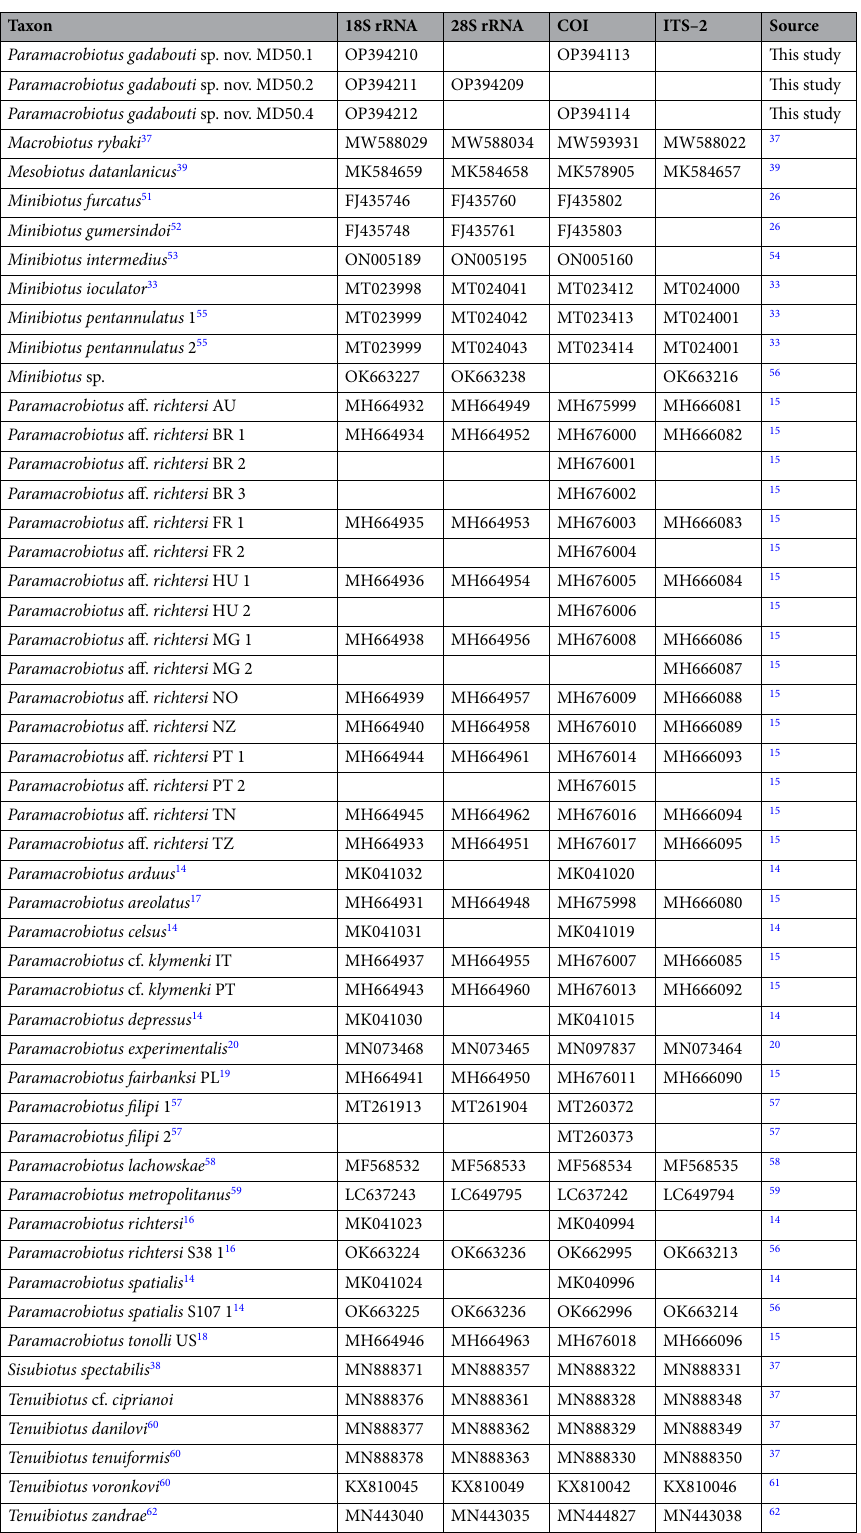
Table 1. Sequences used for phylogenetic analysis. Bold font indicates sequences obtained in this